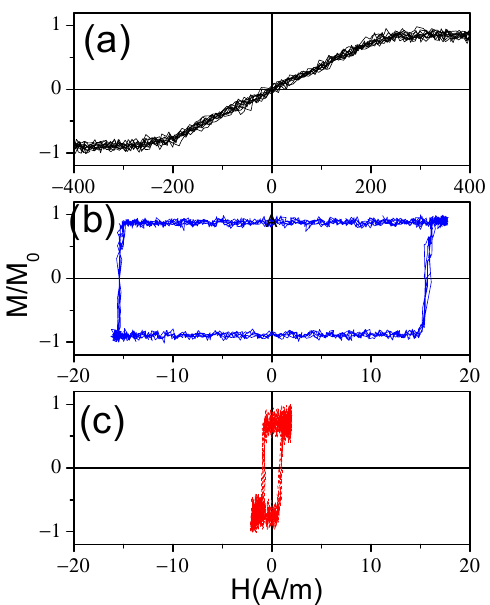
Figure 21. Hysteresis loops of as-prepared ( a ), annealed at T ann = 350 ◦ C ( b ) and stress annealed at T ann = 350 ◦ C and σ m = 250 MPa ( c ) Co 68.7 Fe 4 Ni 1 B 13 Si 11 Mo 2.3 microwires. Adapted from Ref. [102].